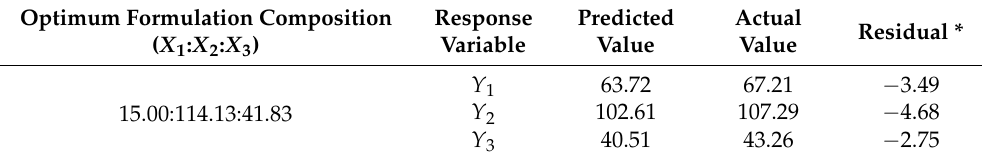
Table 4. Composition, predicted, and actual responses for the optimum QRC-NOVs formulation. Optimum Formulation